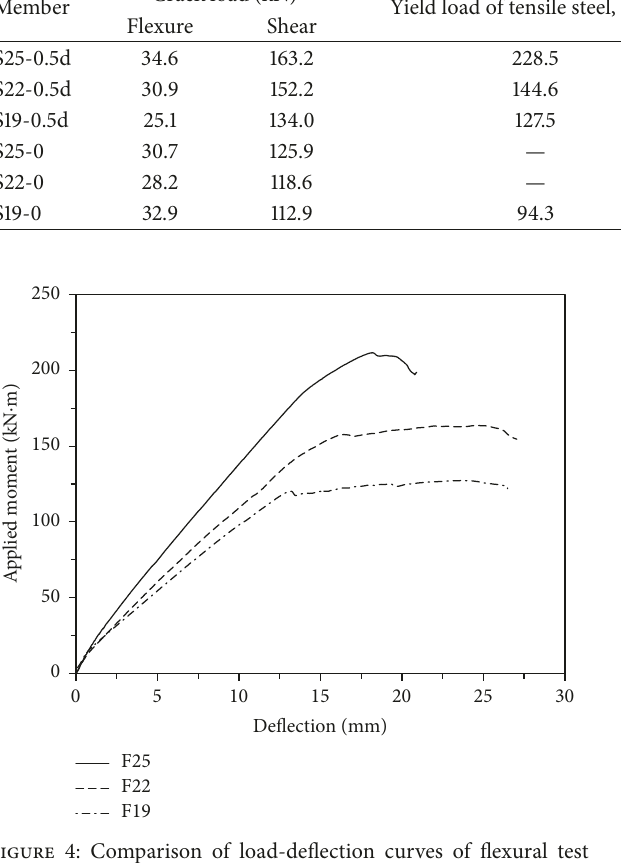
Figure 4: Comparison of load-deflection curves of flexural test